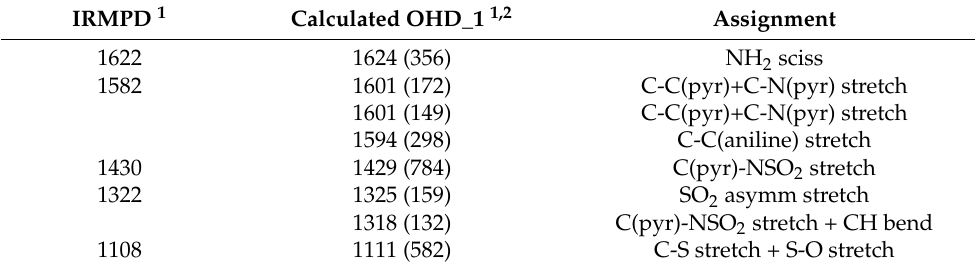
Figure 2. IRMPD spectrum of Zn(H 2 O+SDZ − H) + (bottom panel; dark and pale blue profiles were recorded with and without the use of one attenuator ( − 3 dB), respectively) compared with calculated IR spectra of selected isomers, the optimized structures of which are reported on the right. Relative free energies (enthalpies) at 298 K are reported in kJ mol −1 . Calculations are at the B3LYP/6-311+G(2df,pd) (S = 6-311+G(3df)) level. Computed harmonic frequencies are scaled by a factor of 0.974, except those regarding S-X stretching modes, which are left unscaled. Table 2. Observed IRMPD bands of the Zn(H 2 O+SDZ − H) + complex and calculated vibrational frequencies of OHD_1 .